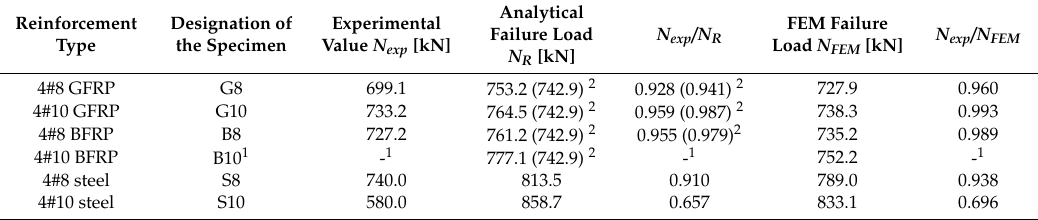
Figure 3. ( a ) Cross-section of the specimen. ( b ) Strain distribution in the cross-section. ( c ) Stress distribution in the cross-section. Table 3. Results of experimental investigations, analytical method, and finite elements method (FEM)